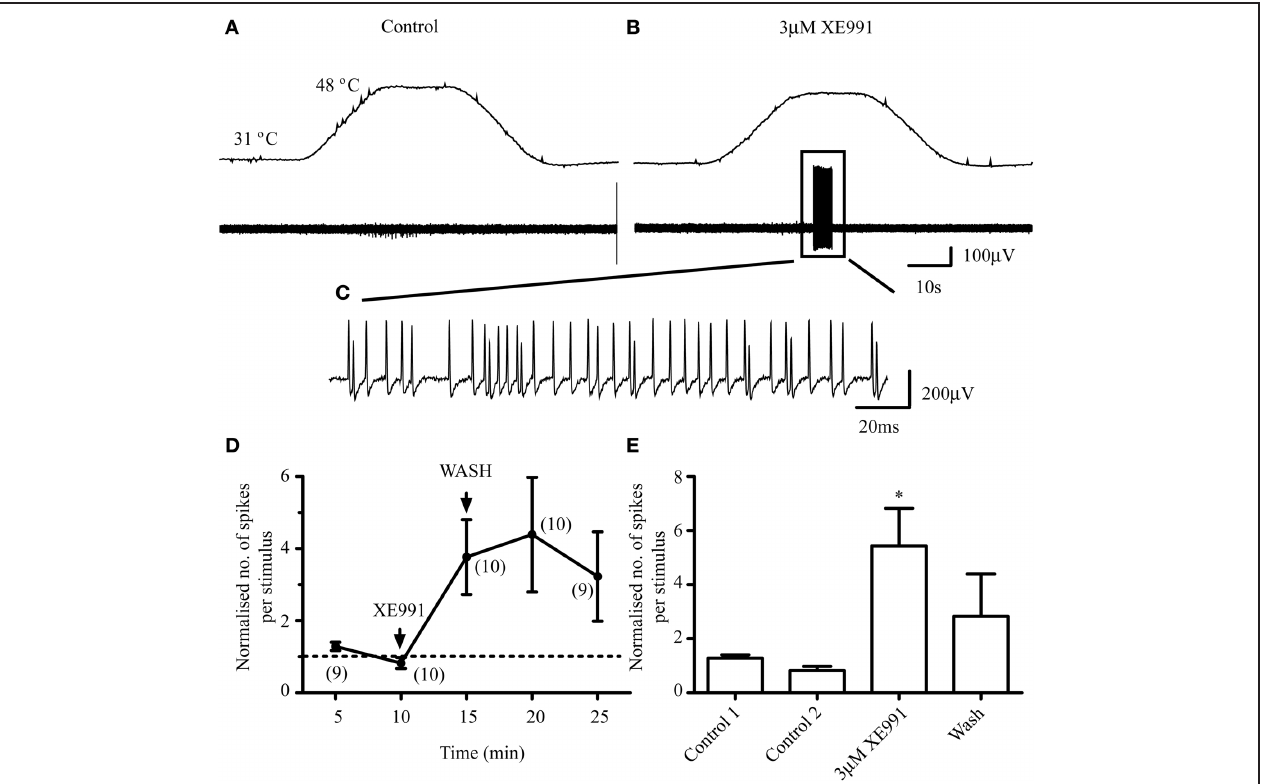
FIGURE 4 | M-channel inhibition sensitizes A δ -fibers to subsequent heat stimulation. An AM-fiber that is unresponsive to noxious heat in control (A) fires action potentials in response to noxious heat following exposure of its receptive field to 3 μ M XE991 (B) The top panels in A and B show the noxious heat ramps that ramp from 31 ◦ C to 48 ◦ C. An expanded time scale of the activity is shown in C. (D) Normalized responses to noxious